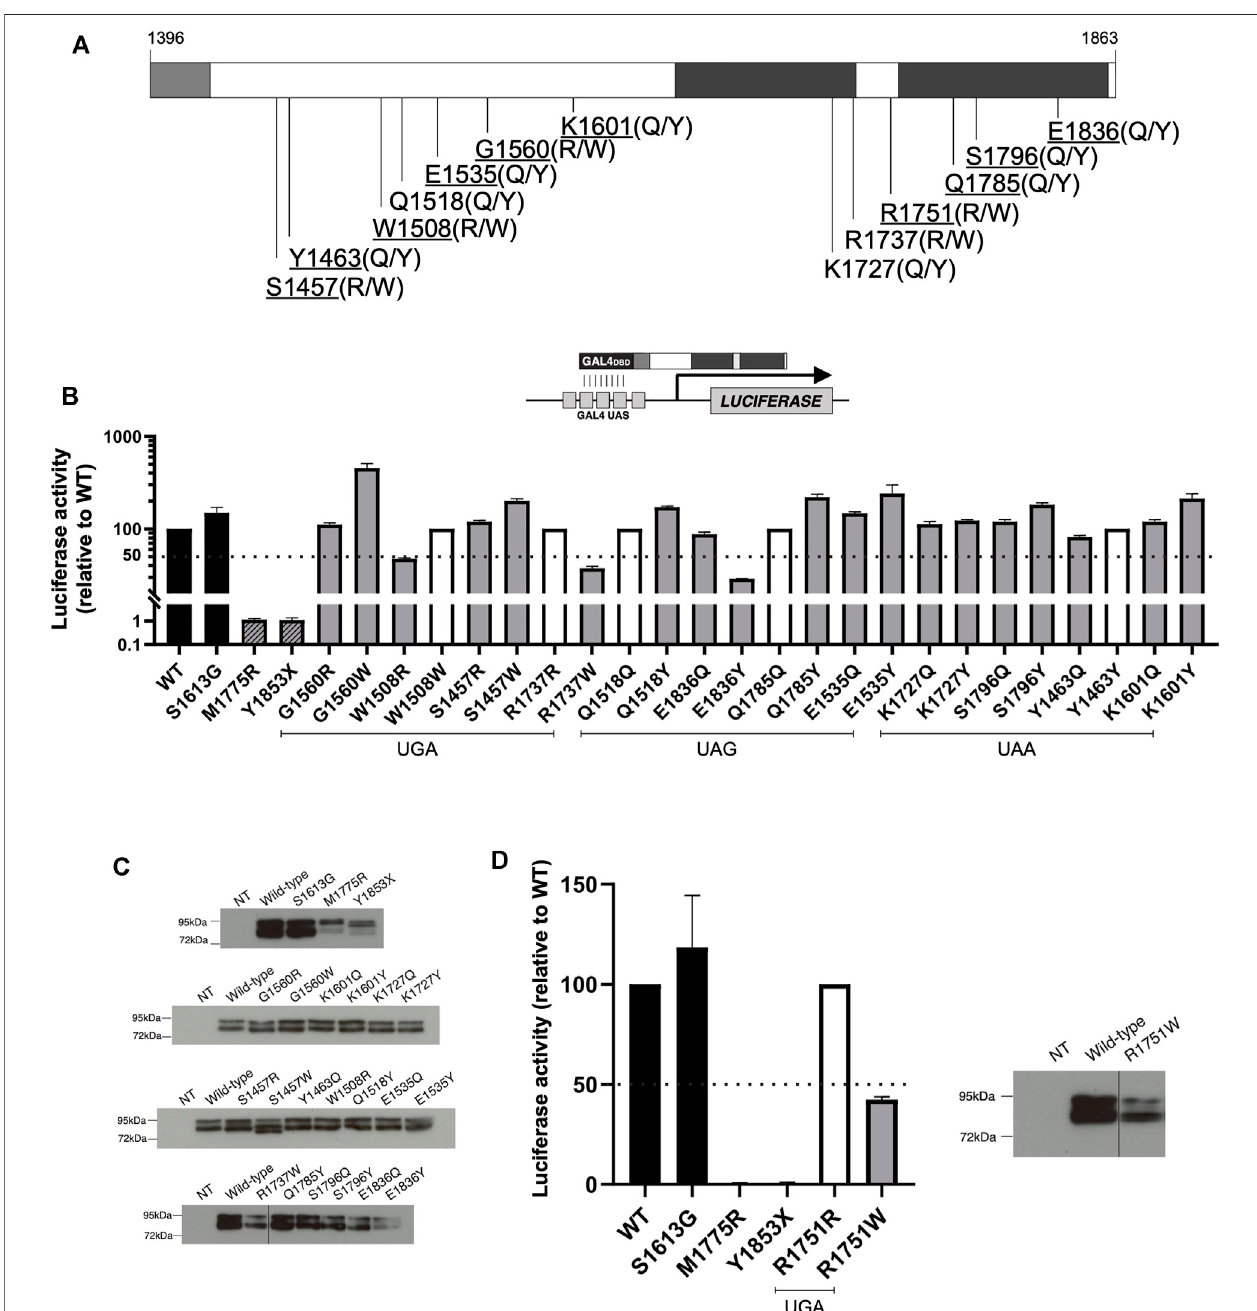
FIGURE 4 | Functional characterization of expected prevalent BRCA1 missense variants generated after PTC readthrough. (A) Schematic representation of BRCA1 C-terminal region encoding amino acid residues 1,396 to 1,863, including part of the coiled-coil (light grey) and the tBRCT (dark grey) domains. WT amino acid residues related to the naturally occurring PTC variants positions are indicated and predicted prevalent amino acid substitutions are shown in parenthesis. The 10 nonsense variants positions that were assessed in this work are underlined. (B) TA assay for predicted readthrough BRCA1 missense variants encoded by GAL4- BRCA1 13/24 constructs was conducted in HEK293FT cells 24 h after transfection using a GAL4-responsive fi re fl y luciferase reporter gene (inset scheme). Functional data are represented relative to WT (WT = 100%). WT and S1613G (black bars) were used as positive controls and M1775R and Y1853X as negative controls (dashed bars). Amino acid substitutions that restore WT sequence are represented by white bars (100% activity). 50% activity level is indicated by the dashed line. Mean and SD of 2 independent experiments. (C) GAL4-BRCA1 13/24 protein levels; immunoblot developed using α -GAL4 DBD antibody. (D) TA assay for predicted readthrough BRCA1 missense variants derived from R1751X PTC (as described for panel B). WT and R1751W GAL4-BRCA1 13/24 protein levels (as described for panel C). NT, non-transfected.